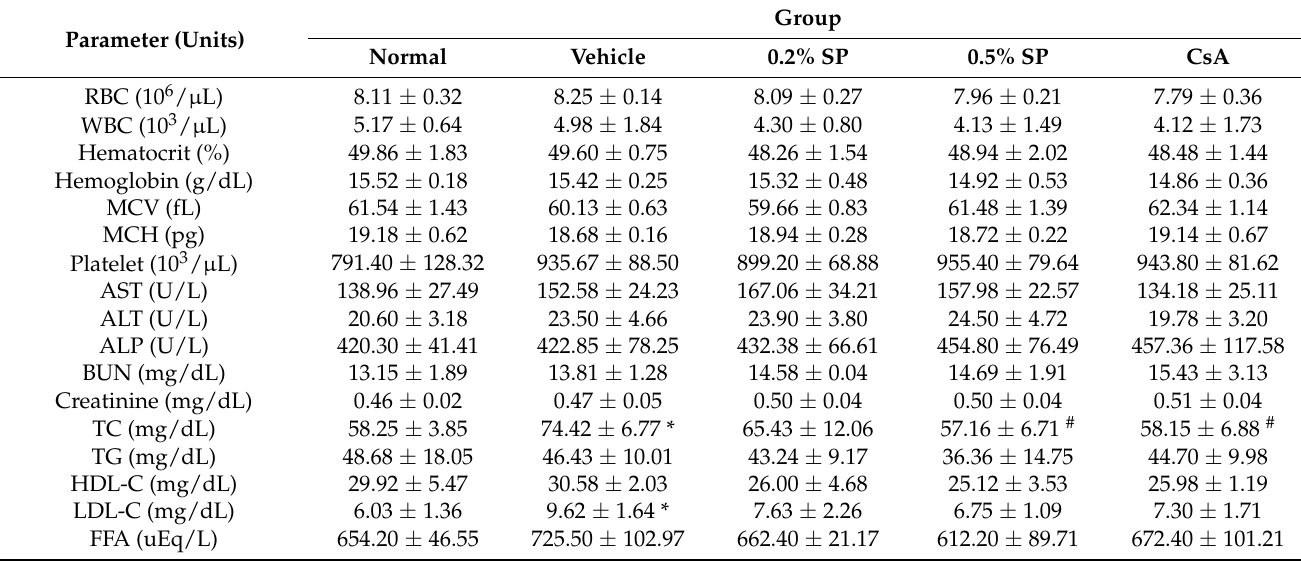
Table 2. Changes in the hematological, biochemical and lipid profiles after 2 weeks of treatment in PM 2.5 -topical exposed SD